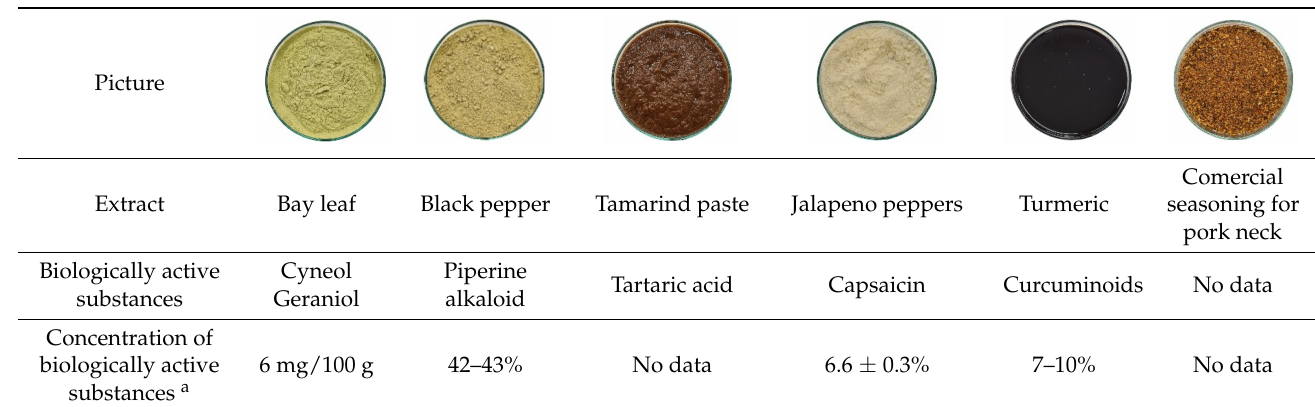
Table 2. Characteristics of plant extracts and tamarind